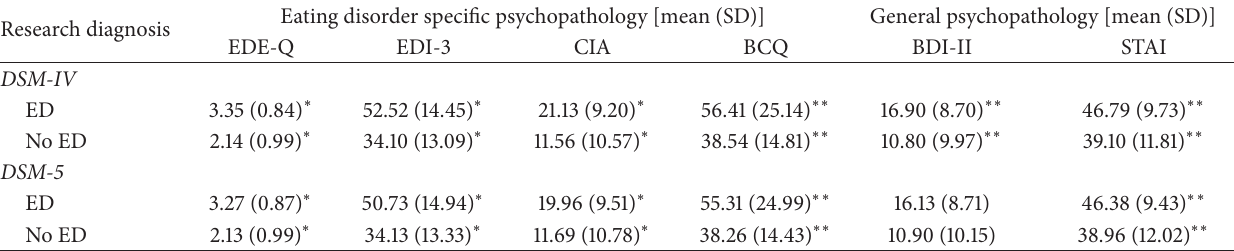
Table 3: Psychopathology comparison measured by self-report scales for DSM-IV and DSM-5 between eating disorder and noneating disorder